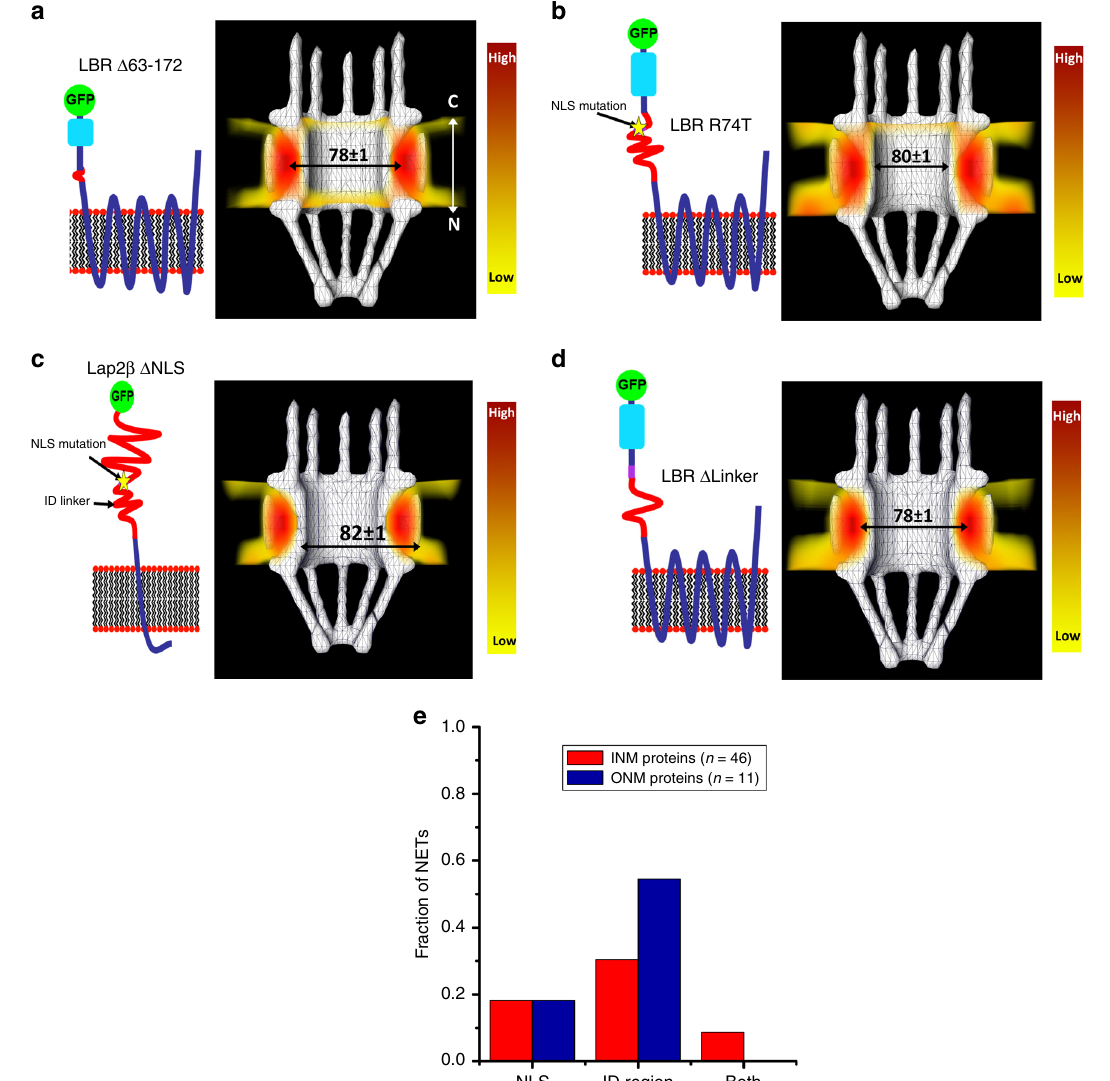
Fig. 4 In vivo transport routes for mutated LBR constructs. a – d Transport routes of N-terminally tagged LBR Δ 63-172, LBR R74T, Lap2 β Δ NLS, and LBR Δ Linker respectively. On the left, schematic cartoon representation of each INM protein (orientation N-terminus to the left and C-terminus to the right). The depicted membrane represents a single bilayer of the NE. On the right, 3D probability density map generated by using the 2D to 3D transformation algorithm 52 , with regions of highest to lowest density (red to yellow in color bar). e Bioinformatic analysis of the fraction of con fi rmed INM proteins (red, n = 46) and ONM proteins (blue, n = 11) that have a strong NLS sequence, an ID region longer than 65 amino acids, and both of those characteristics arranged in a way that is feasible for transport through the facilitated transport route using both central and peripheral channels of the